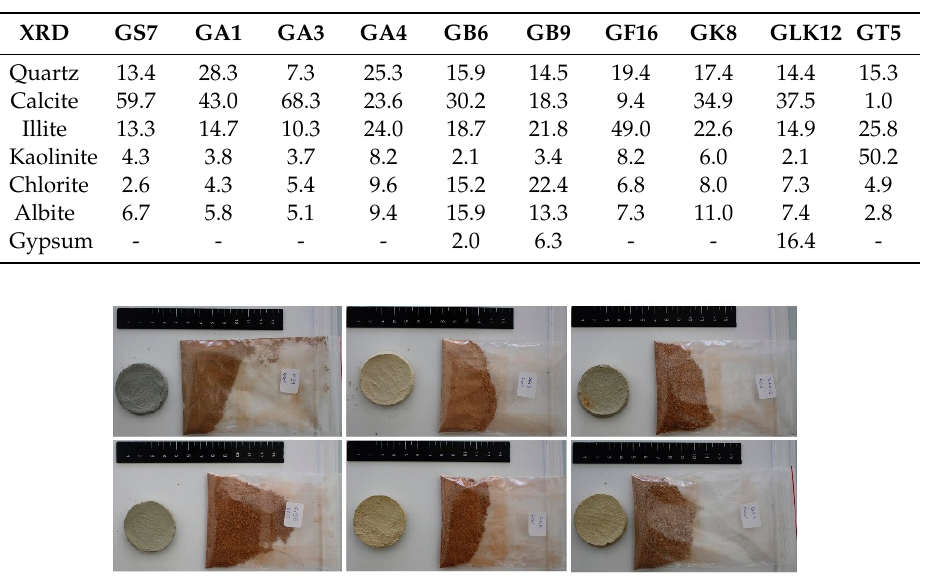
Figure 8. Colour change after heat treatment for samples GLK12, GS7, GA3 (upper, left to right), GK8, GB9, GB6 (down, left to right).